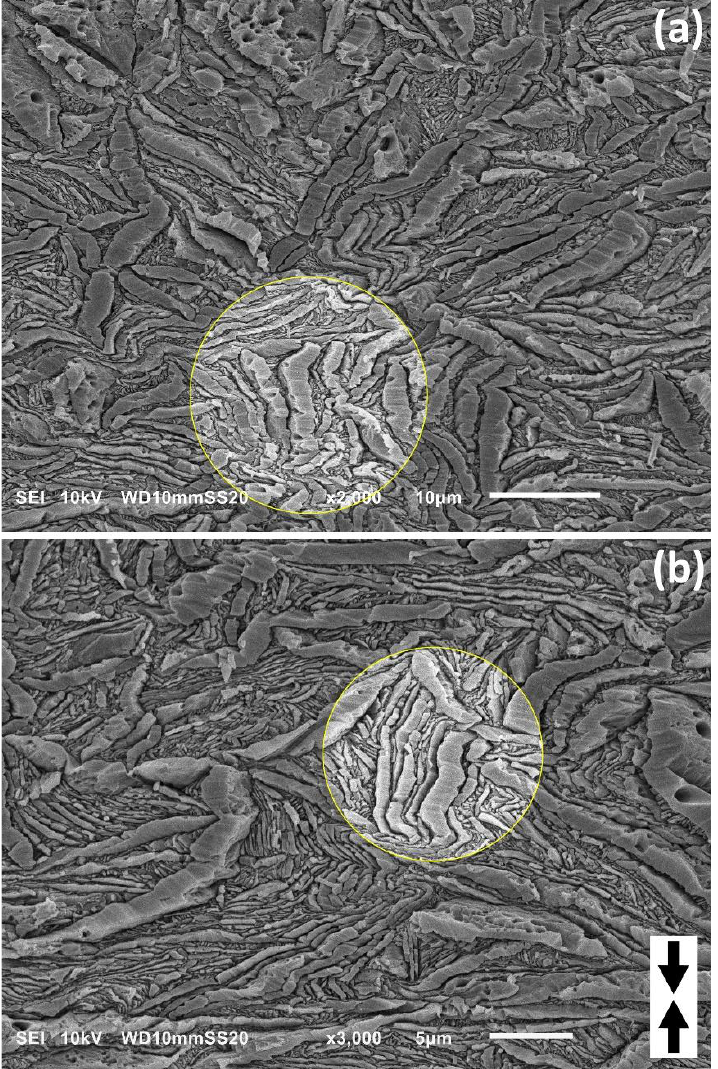
Figure 9. SEM micrographs of the H4-CE sample deformed by uniaxial compression to the true strain of e = 0.5. The micrographs (a) and (b) show two different regions of the same sample. The direction of compression is vertical. Sample etched prior to observation.